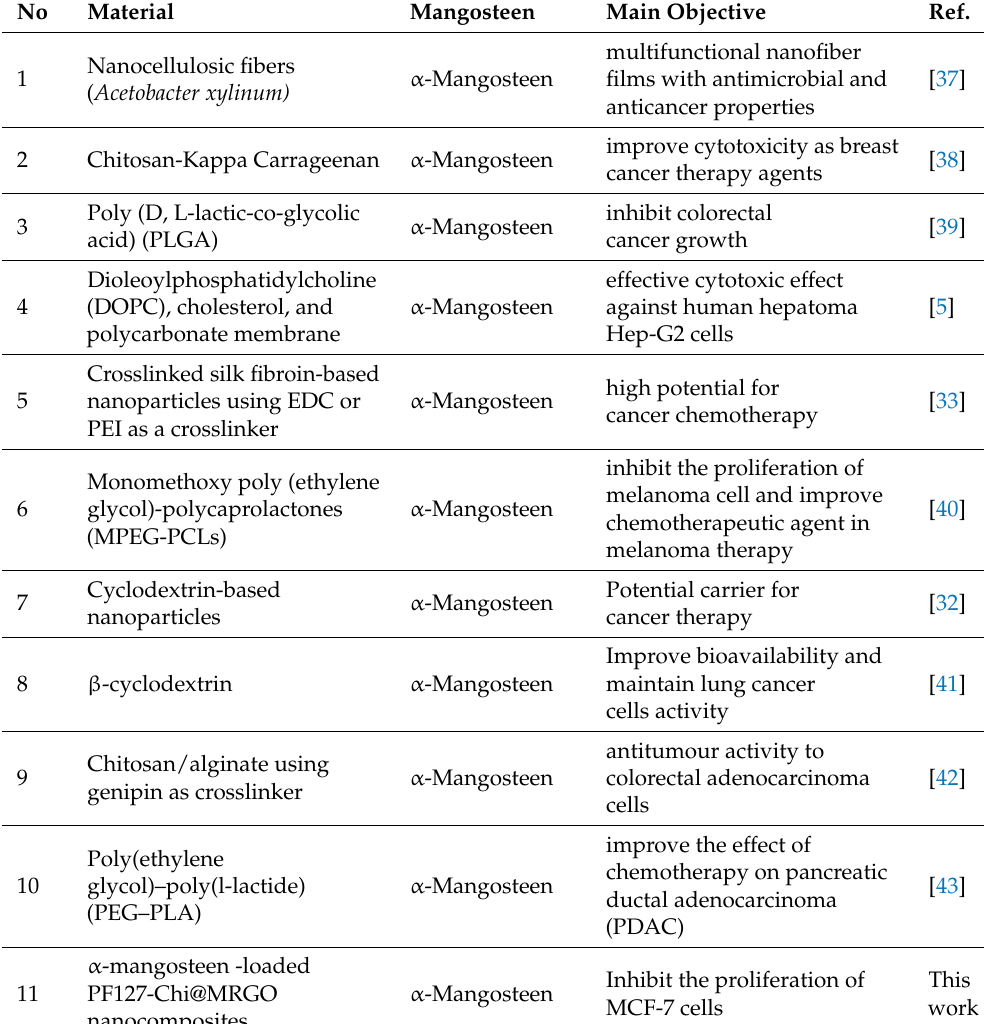
Table 1. Recent nanoparticle formulation of mangosteen for drug delivery systems